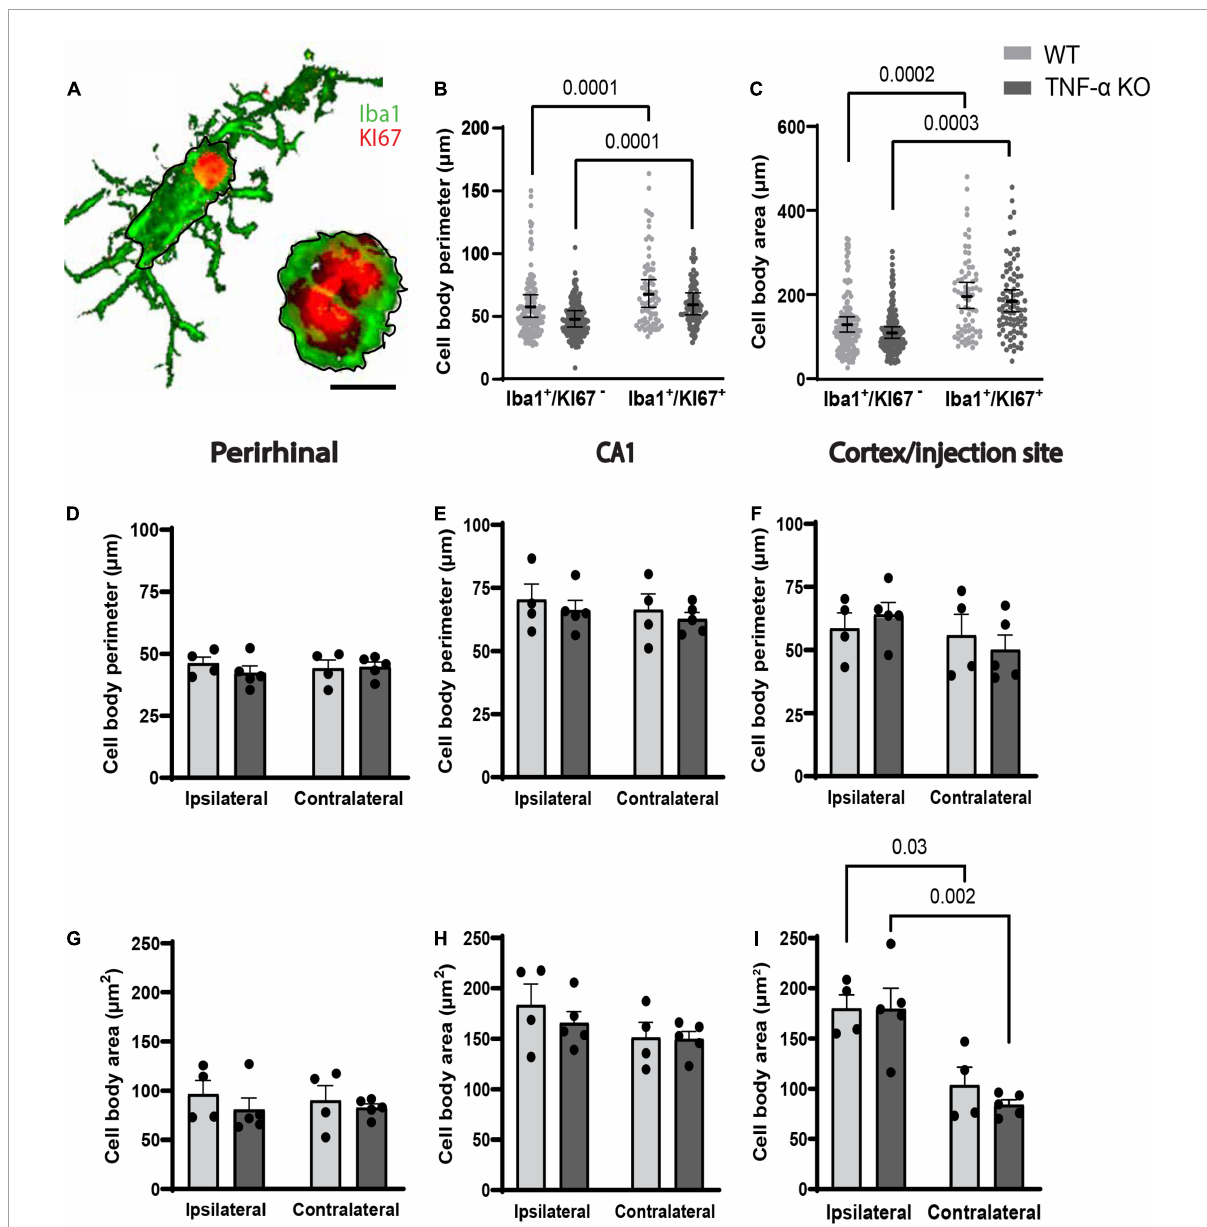
FIGURE3 Dividing microglia had larger cell body areas and longer perimeters compared to microglia that were not dividing. (A) Iba1 + microglia were randomly selected, and the area and perimeter were traced and calculated in ImageJ (represented by black lines around the cell bodies). Scale bar = approximately 10 µ m. (B) Cell body perimeter and (C) cell body area of individual microglia. (B,C) Individual data points are presented as dots and were analyzed using linear mixed models. Results are presented as point estimates with 95% confidence intervals (see Table 2 ). Statistically significant post hoc comparisons are indicated by bars with corresponding p -values. Iba1 + /KI67 + = colocalization of Iba1 and KI67. TNF- α KO KI67 - n = 181 microglia; WT KI67 - n = 139 microglia; TNF- α KO KI67 + n = 87 microglia; WT KI67 + n = 71 microglia. (D–I) Microglia were quantified in three images and averaged per animal for three regions of interest. (D) Average cell body perimeter of microglia in the perirhinal cortex, (E) CA1, and (F) cortex/injection site. (G) Average cell body area of microglia in the perirhinal cortex, (H) CA1, and (I) cortex/injection site. (D–I) Data are presented as mean ± SEM. Data were analyzed using a two-way ANOVA (see Table 3 ). Statistically significant post hoc comparisons are indicated by bars with corresponding p -values. WT n = 4; TNF- α KO n =